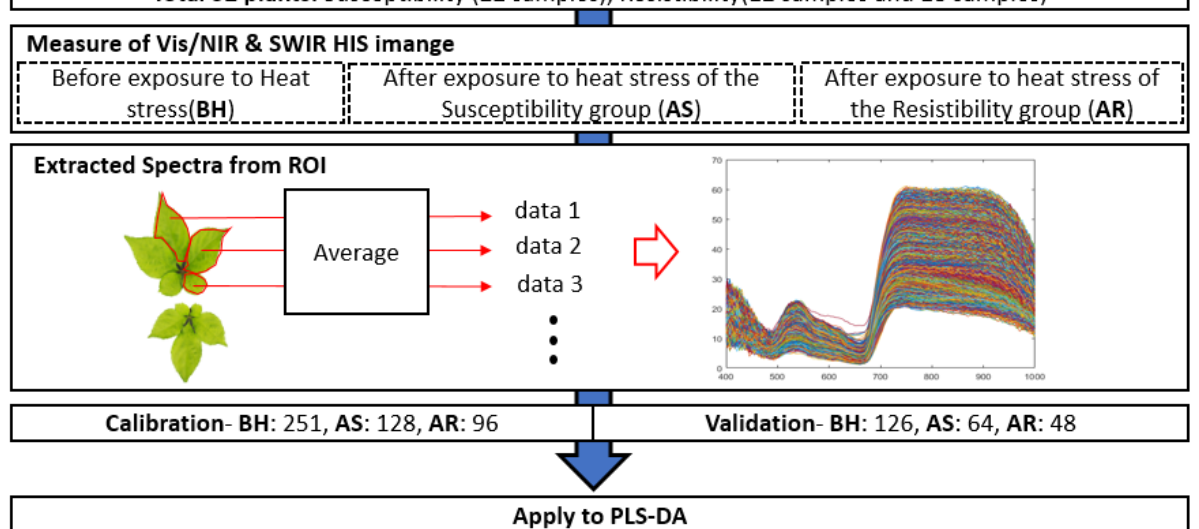
Figure 2. Diagram of data extraction process.